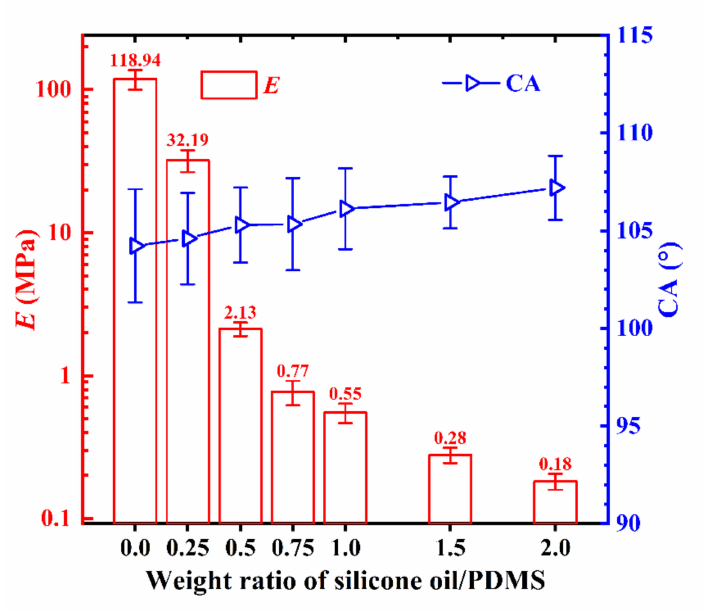
Figure 12. E and CA versus the weight ratio of silicone oil to epoxy/polydimethylsiloxane